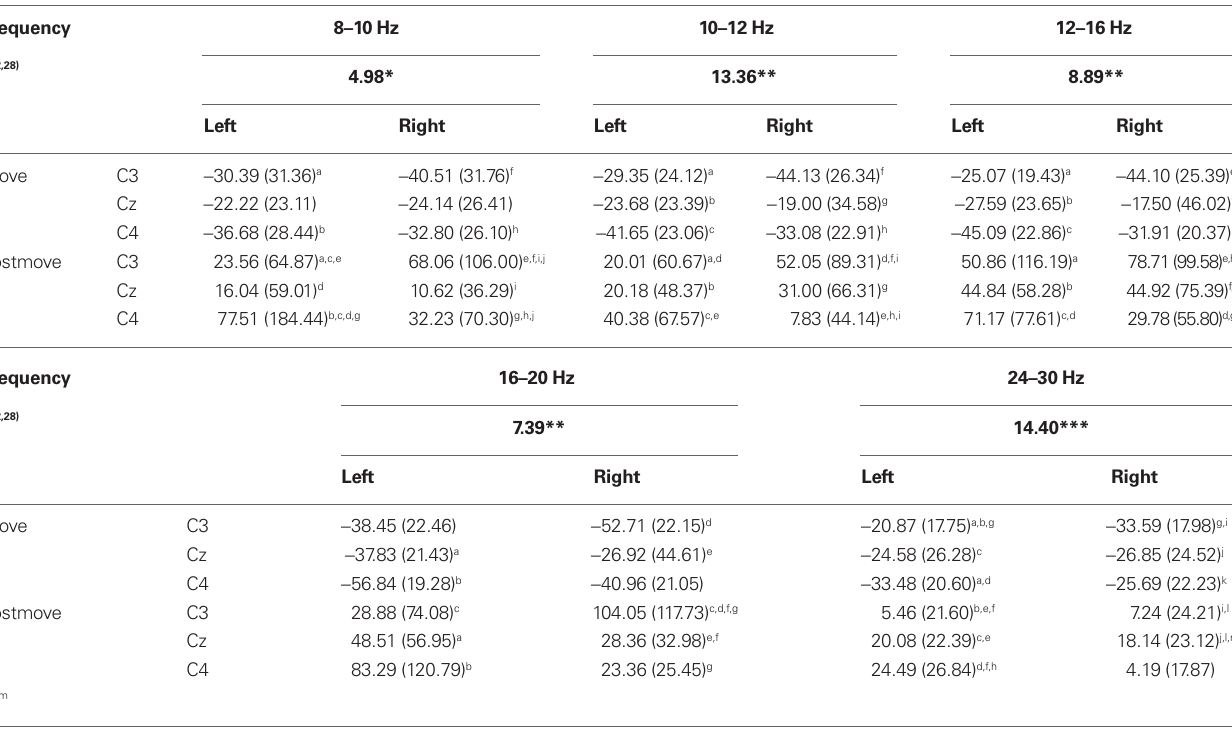
Table 3 | F -values, mean, and SD of erD/erS values for the significant interaction “hand × phase × position” in passive movement task.